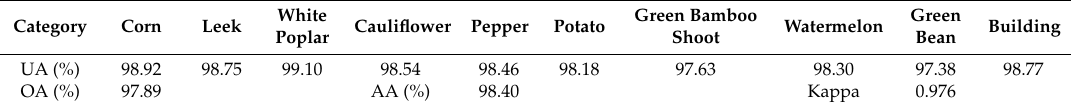
Table 4. Ground object classification accuracy based on multi-scale dilated residual networks (M-DRN).